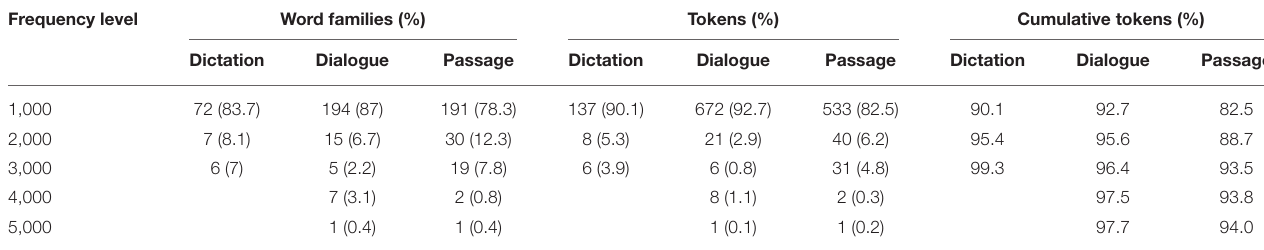
TABLE 4 | Frequency analysis of the lexical content of the three listening tests.